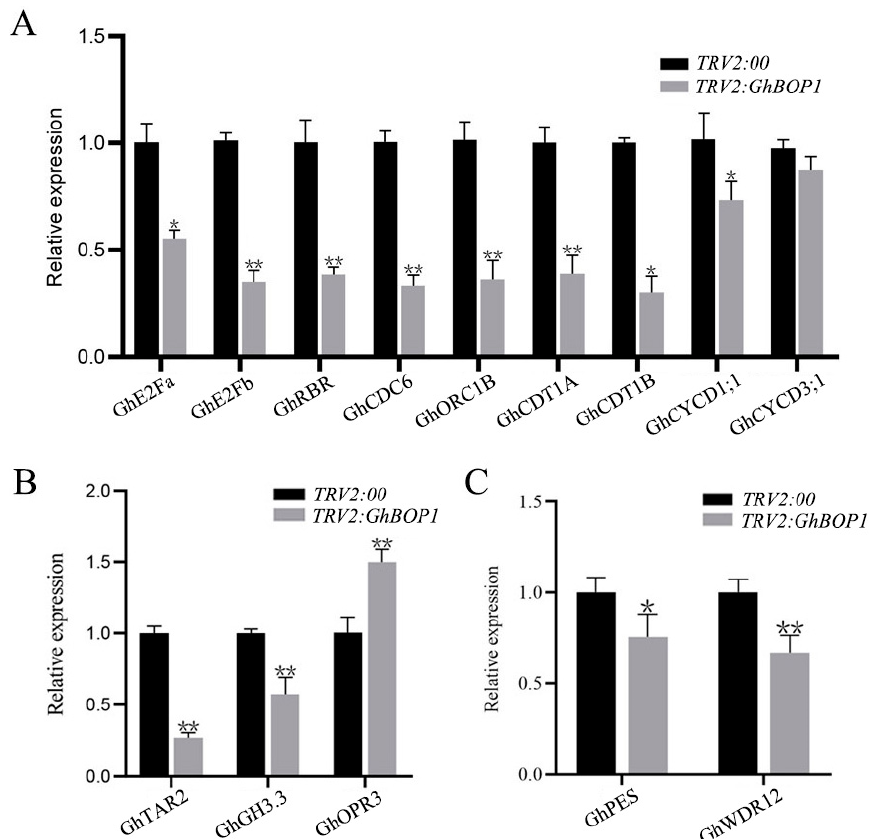
Figure 5. Expression of interacting genes, cell cycle-, auxin- and jasmonic acid-related genes in GhBOP1- silenced lines during early response. ( A ) Expression of cell cycle-related genes. ( B ) Expres- sion of auxin- and jasmonic acid-related genes. ( C ) Expression of GhBOP1 interacting genes. The data were tested by conducting the one-way analysis of variance (ANOVA) with the aid of the Student’s t -test at the significant level as follows: * p ≤ 0.05; ** p ≤ 0.01. The error bars indicate standard error from three independent repeated trials.